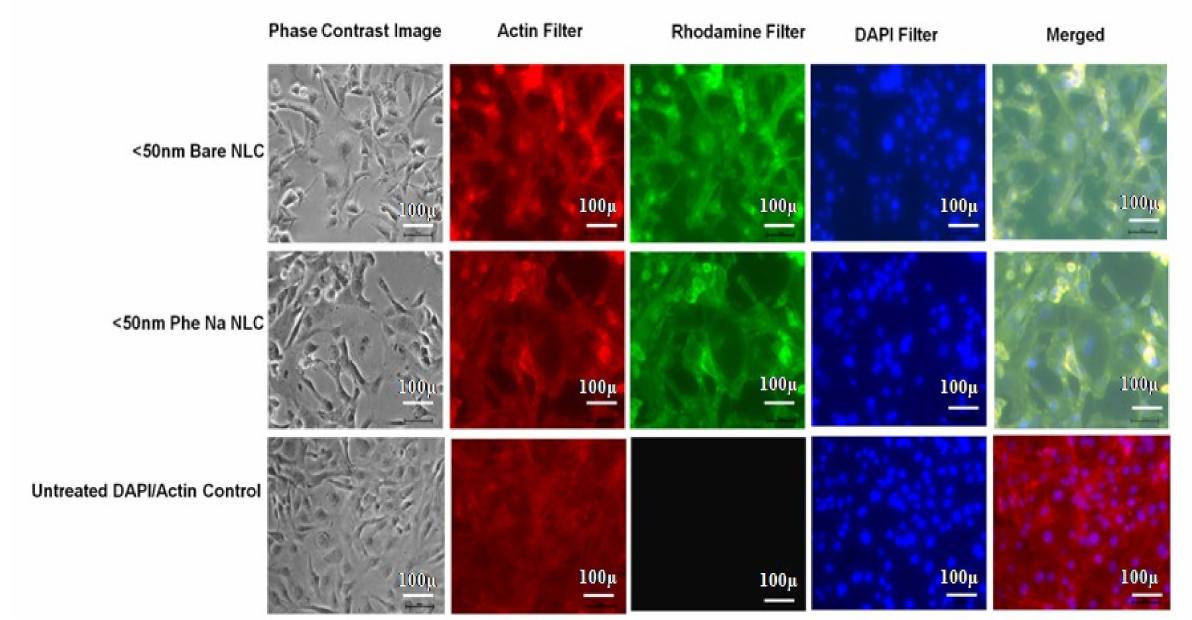
3.6. Human Brain Capillary Endothelial Cell (HBCEC) Uptake Using Fluorescent Microscopy The cell uptake of phenytoin sodium NLCs by human brain capillary endothelial cells (HBCEC) was determined by using fluorescent microscopy. To detect the NLC particle using fluorescent microscopy, we labelled the control as well as the <50 nm sized bare NLCs and the <50 nm sized phenytoin sodium NLCs with a lipophilic fluorescent Rhodamine 123 dye. After removing the unconjugated rhodamine fraction by centrifugation process, the rhodamine bound NLCs were taken for BCEC cell uptake studies. After staining the cells by using Actin and DAPI followed by fluorescent microscopy imaging, internalizations of rhodamine tagged <50 nm sized bare NLCs and drug loaded NLCs by HBCEC cells were determined. Actin provides red colour stain to the cytoskeleton of the cell, and DAPI stains the nucleus of the cells as blue. The combined control cell images showed the cytoskeleton of cells having rounded nucleus. In rhodamine -tagged NLC treated cell lines, the presence of rhodamine-conjugated particles is observed in green colour, and the combined images show the presence of particles in the entire BCEC cells (Figure 6). The intensity of green color was prominent for <50 nm sized NLC treated cells, which confirms that the size of the particle plays an important role in cell uptake. This phenomenon may result from the higher affinity of NLC’s biocompatible lipid materials for the HBCEC cell membrane and the nano size of particles [44].